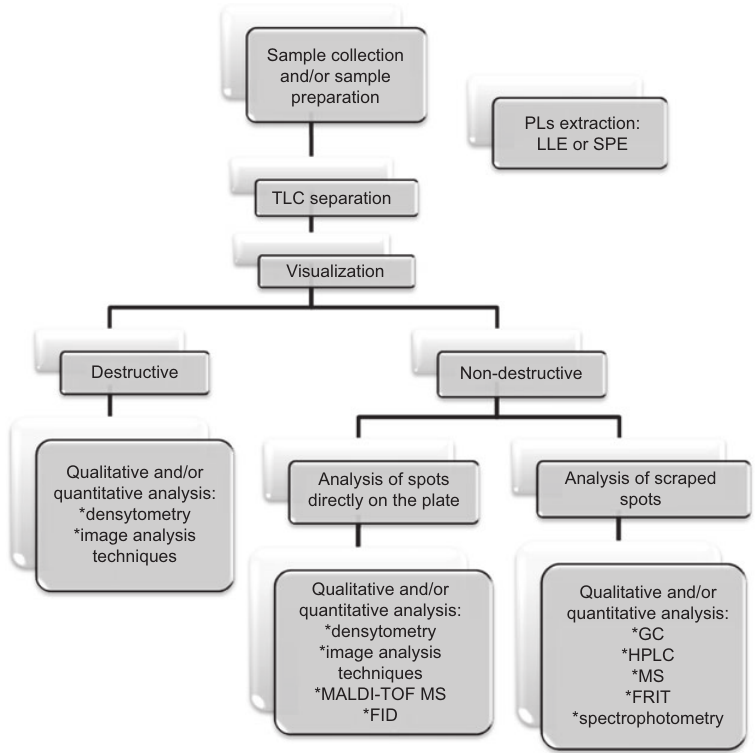
Figure 8 The general scheme for PL determination with the use of